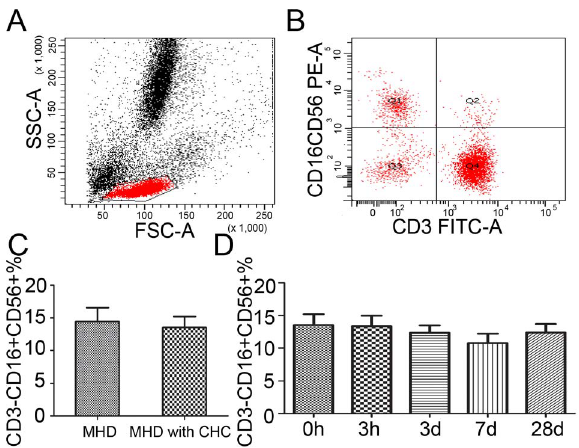
Figure 3. The percentages of NK cells in PBMC after the DFPP. A, B. NK cell was expressed as CD3–CD16 + CD56 + cells in PBMCs. C. The frequencies of NK cells in MHD patients with CHC compared to those without CHC. D. The frequencies of NK cells in MHD patients with CHC during the DFPP.